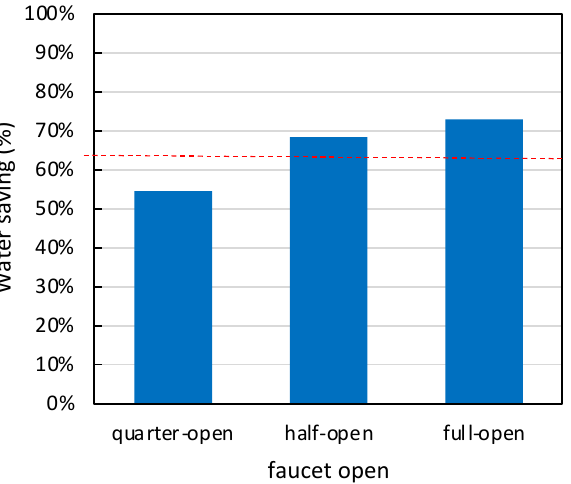
Figure 11. Average water savings of four types of fittings at different faucet openings ( n = 4).